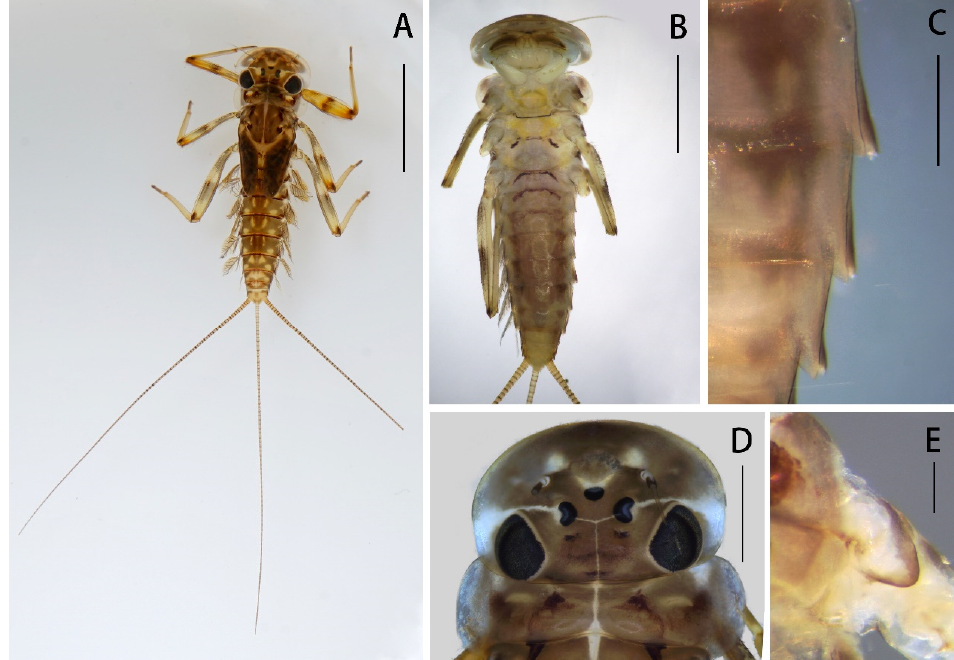
Figure 1. Nymph of Regulaneuria cingulata : ( A ) Nymphal habitus; ( B ) Ventral surface of nymph; ( C ) Posterolateral projections of terga V–VII (ventral view); ( D ) Head capsule and pronotum; ( E ) Supracoxal spur (midleg). Scale bars: ( A ) = 5.0 mm; ( B ) = 2.0 mm; ( C ) = 0.5 mm; ( D ) = 1.0 mm; ( E ) = 0.1 mm.